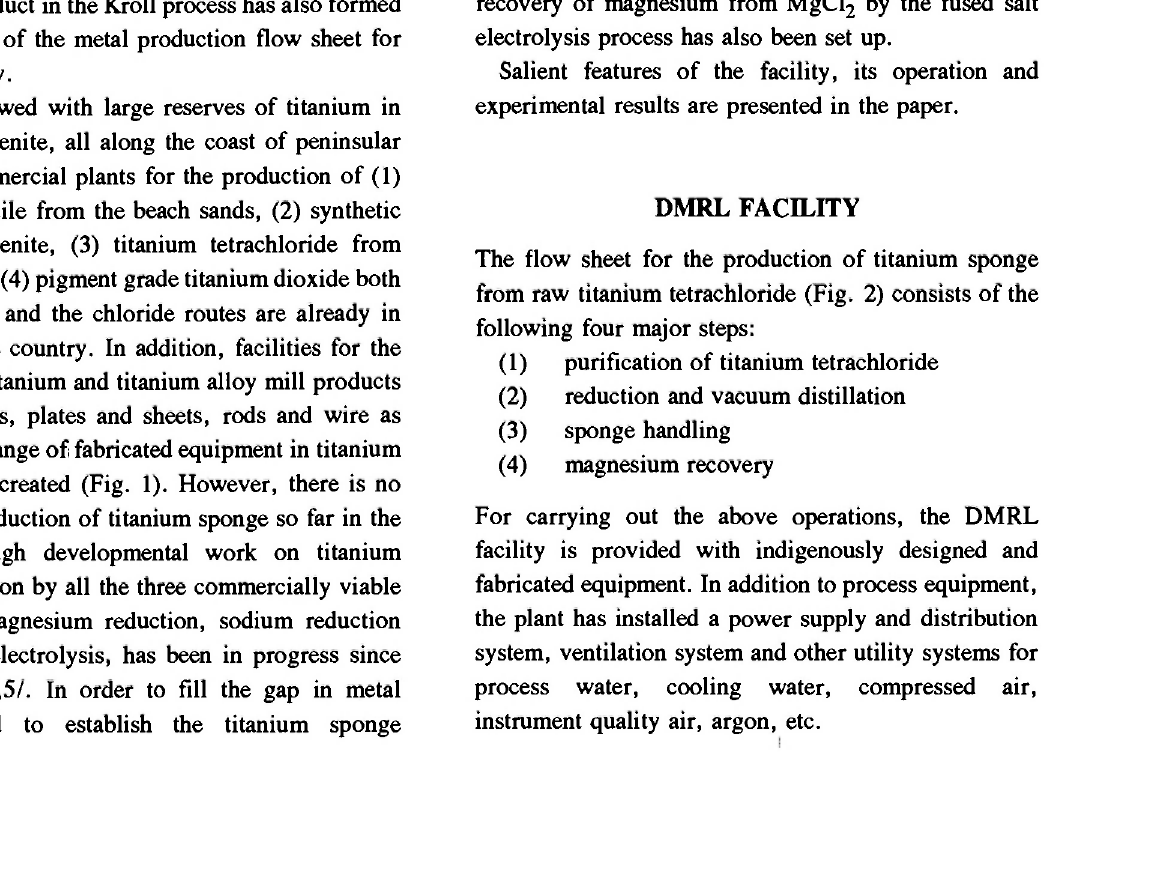
Fig. 1: Indian Ti scene